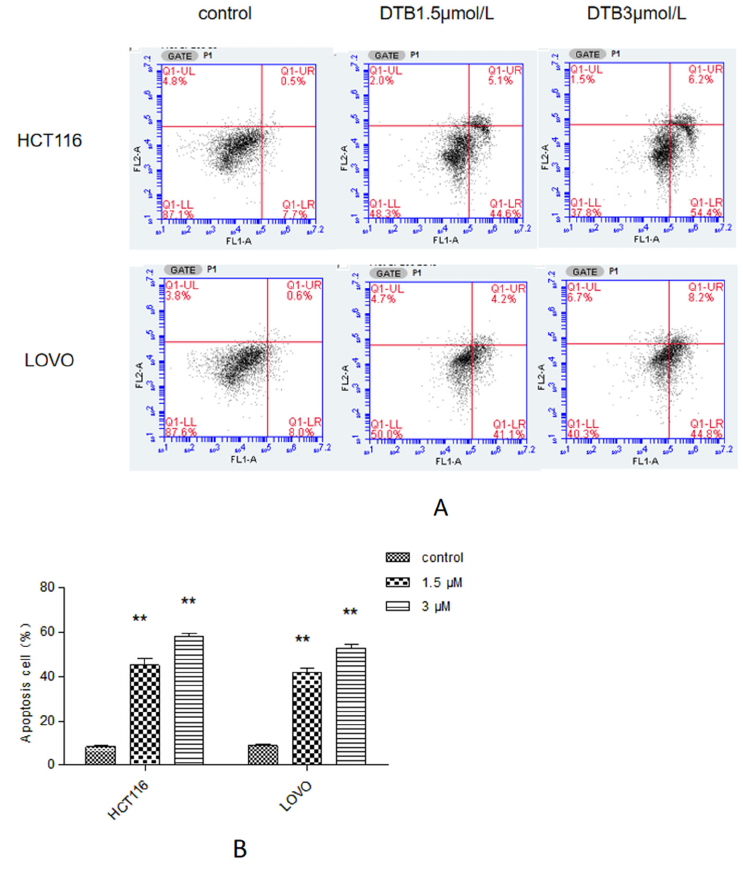
Figure 6. ( A ) Flow cytometry to detect the apoptosis rate of colon cancer cells HCT116 and LOVO after DTB intervention. (Q1-UR: the late apoptotic cells; Q1-LR: the early apoptotic cells. The ab- scissa is Annexin V FITC staining, and the ordinate is PI staining.) ( B ) Flow cytometric detection of the apoptotic rate of colon cancer cells. n = 3; compared with the blank group, ** p < 0.01, each data point represents the mean ± standard deviation.